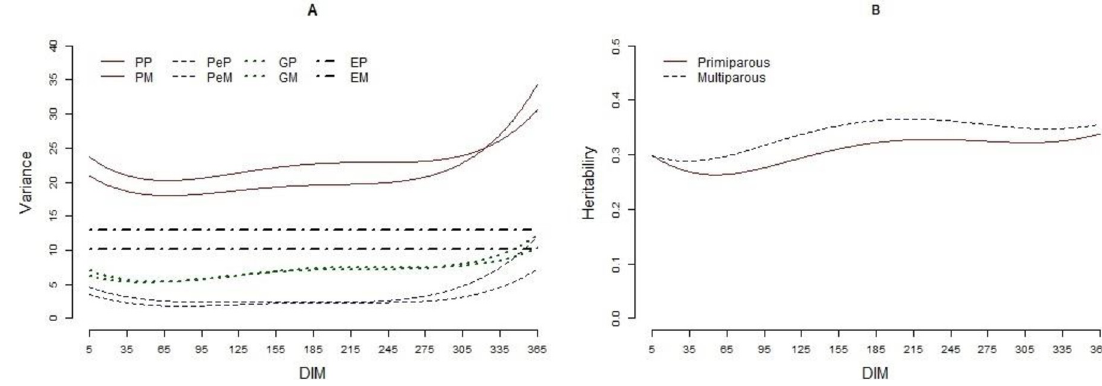
Fig 2. Variance components (A) and heritability (B) of MU in primiparous and multiparous cows. Phenotypic variance in primiparous (PP), phenotypic variance in multiparous (PM), permanent environmental variance in primiparous (PeP), permanent environmental variance in multiparous (PeM), genetic variance in primiparous (GP), genetic variance in multiparous (GM).